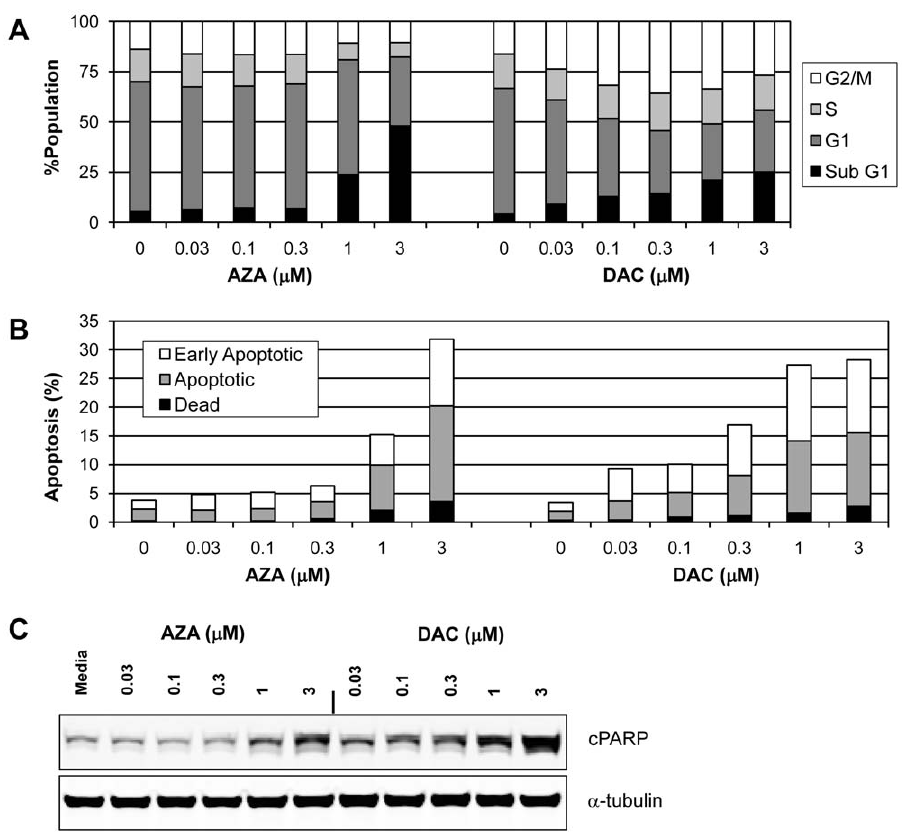
Figure 6. Effects of AZA and DAC on cell cycle and apoptosis in KG-1a cells. KG-1a cells were treated daily with AZA or DAC (0–3 m M) for 48 hours. ( A ) Cell cycle effects of AZA and DAC. Cells were stained with NIM-DAPI and quantification by flow cytometry for percentage of cells in sub- G1, G0/G1, S, and G2-M phases (normalized to 100%). ( B ) AZA and DAC induce apoptosis in KG-1a cells. Apoptosis was detected with flow cytometry by positive staining for Annexin V (early apoptosis) and 7-AAD (late apoptosis). ( C ) Protein lysates were analyzed by Western analysis for detection of PARP cleavage. a -Tubulin is shown as a protein loading control. AZA = azacitidine; DAC = decitabine. doi:10.1371/journal.pone.0009001.g006 (1–3 m M) regulated a greater number of genes compared with DAC (1–3 m M). Gene expression values are provided in Table S2 . Venn analysis of the genes modulated by each drug revealed